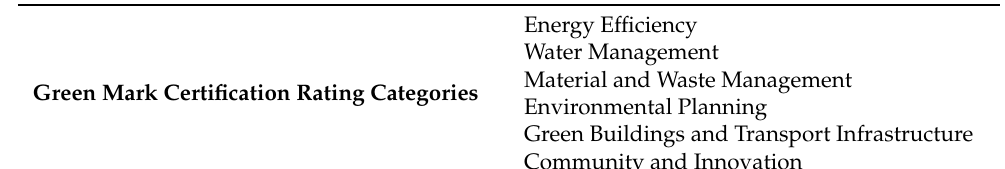
Green Mark Certification Rating